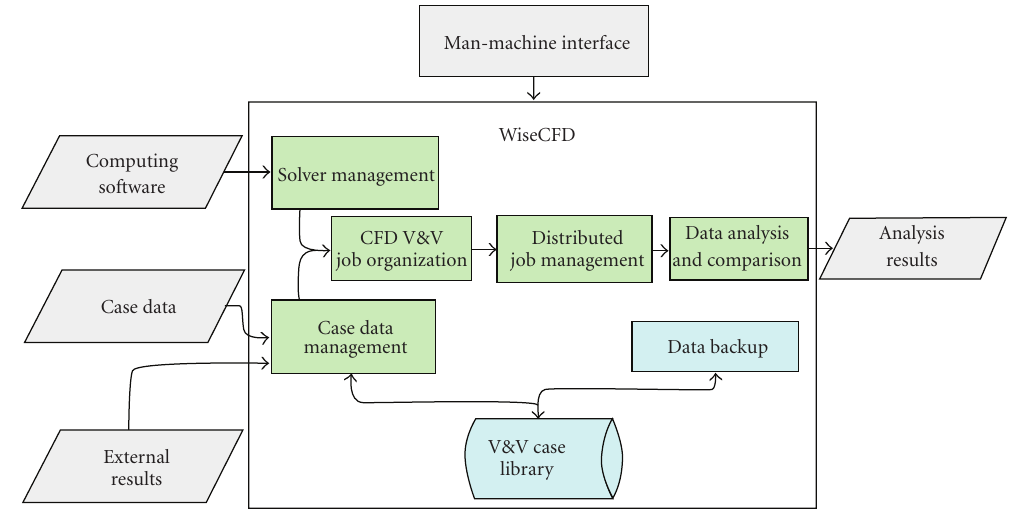
Figure 6: System architecture of the WiseCFD